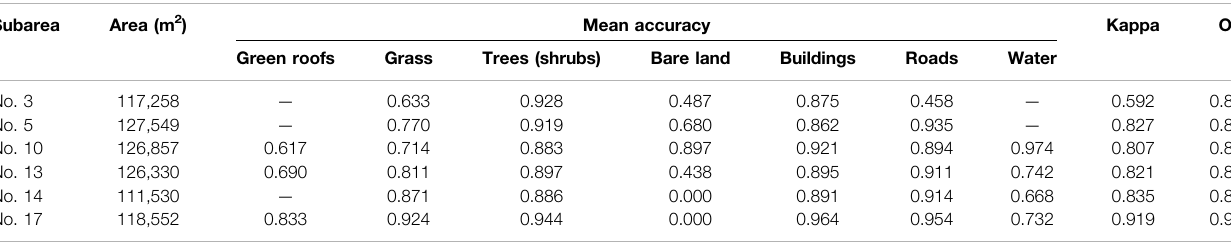
TABLE 3 | Classi fi cation accuracy assessment in different subareas. Subarea Area (m 2 )